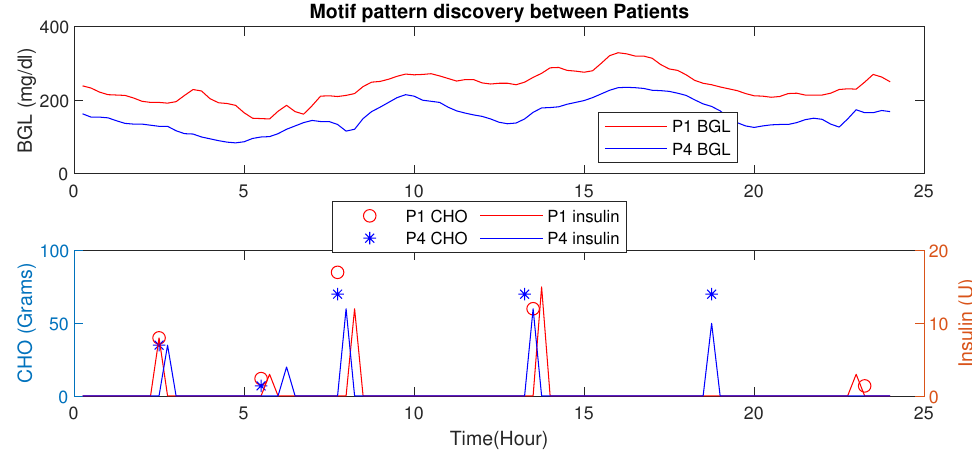
Figure 20. Motif Discovery between patient P 1 & P 4 : Motif shows days with similar patterns. Patient P 4 has lower BGL than P 1 due to active lifestyle and relatively lower co-morbid conditions.